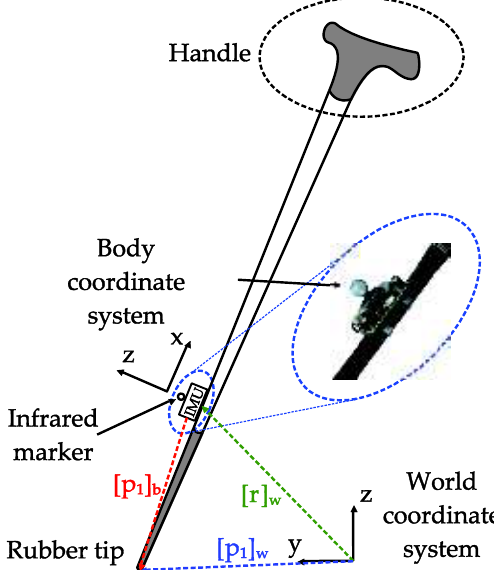
Figure 2. Standard cane with an attached inertial sensor and infrared marker.